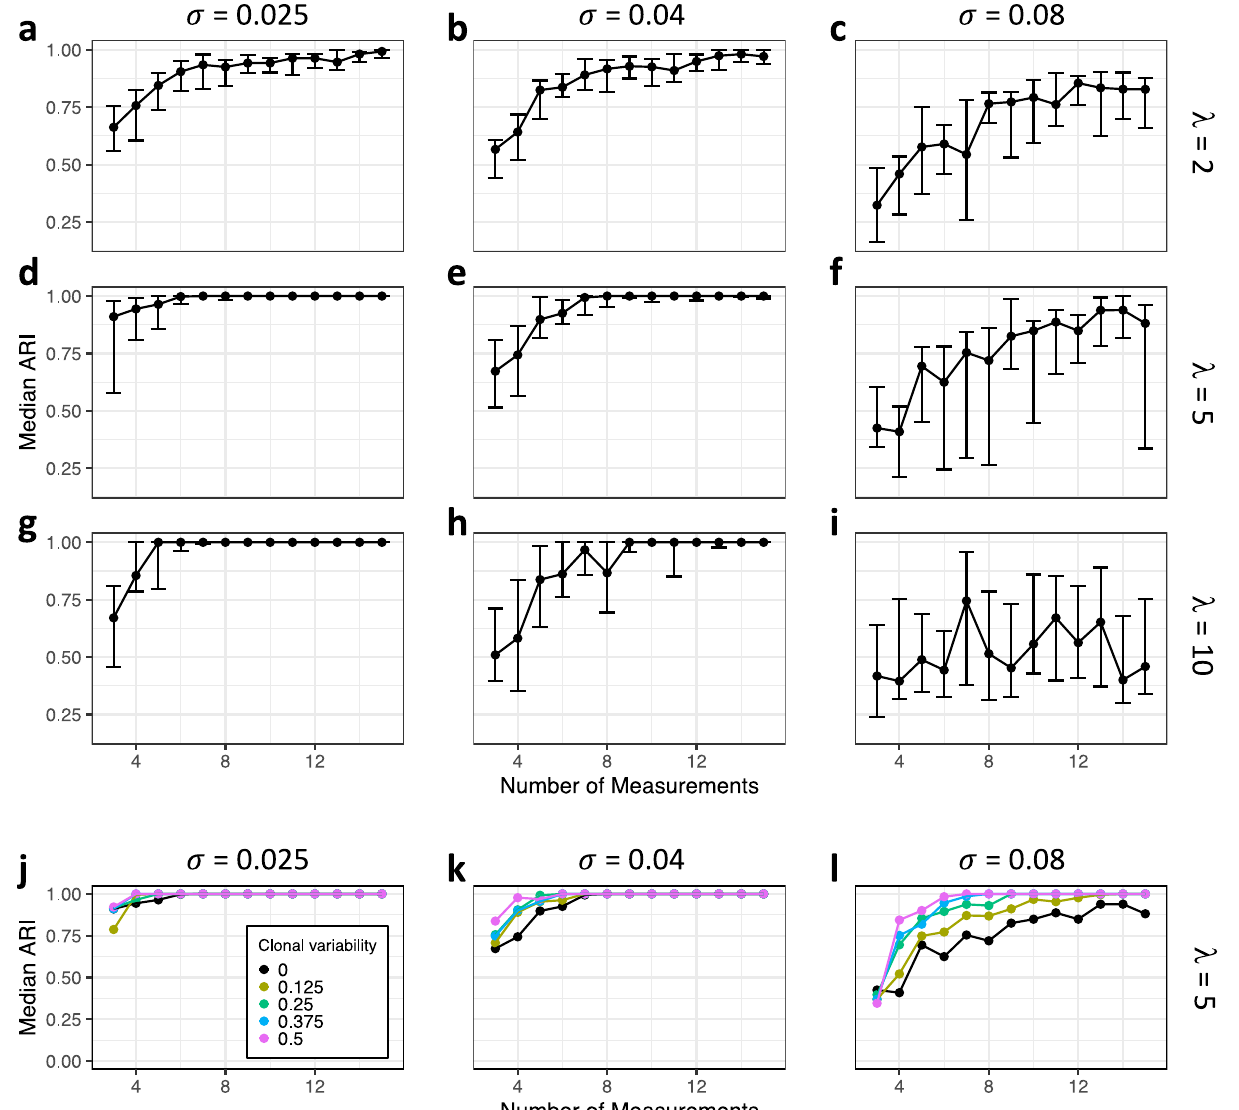
Fig. 4 Dependencies of the reconstruction quality. a – i Reconstruction quality with respect to the average number of IS λ and levels of measurement noise σ for standard deviation of the differentiation rate δ = 0.0025. Rows refer to the average number of IS λ = 2 ( a , b , c ), λ = 5 ( d , e , f ) and λ = 10 ( g , h , i ). The column represents increasing levels of the measurement noise σ = 0.025 ( a , d , g ), σ = 0.04 ( b , e , h ) and σ = 0.08 ( c , f , i ). Each data point is based on 20 independent simulation runs (points indicate the median adjusted Rand index (ARI); whiskers correspond to the fi rst and third quartile). j , k , l Reconstruction quality depends on clonal variability ν . Median ARI is shown as a function of the number of measurements for increasing levels of measurement noise σ = 0.025 ( j ), σ = 0.04 ( k ) and σ = 0.08 ( l ). The coloring corresponds to different levels of the clonal variability ν , which approximates the diversity of available compartments. Each data point is based on 20 independent simulation